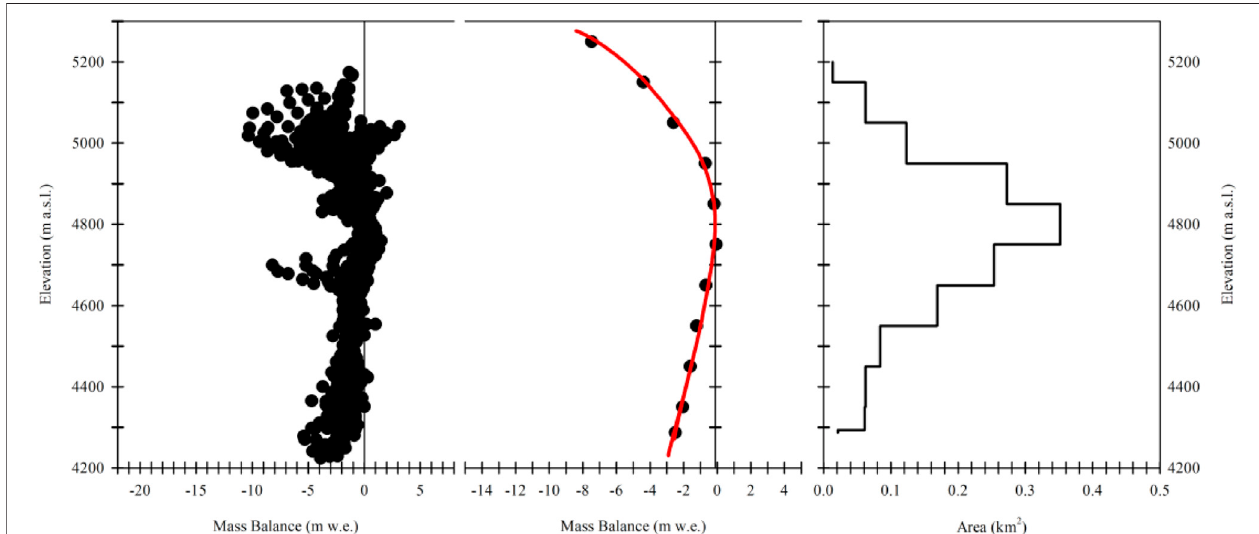
FIGURE 6 | Relationships between (A) elevation, (B) mass balance, and (C) area for the Baishui River Glacier No. 1.